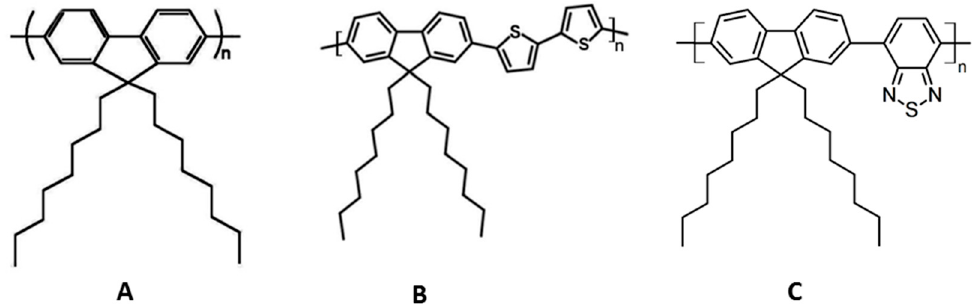
Figure 1. Structures of the CPs used: ( A ) poly[9,9-dioctylfluorene-2,7-diyl] (PFO); ( B ) poly[(9,9-dioctylfluorenyl-2,7-diyl)-co-bithiophene] (F8T2); and ( C ) poly[(9,9-dioctylfluorenyl-2,7-diyl)-alt-co-(1,4-benzo-2,10,3- thiadiazole)] (F8BT).